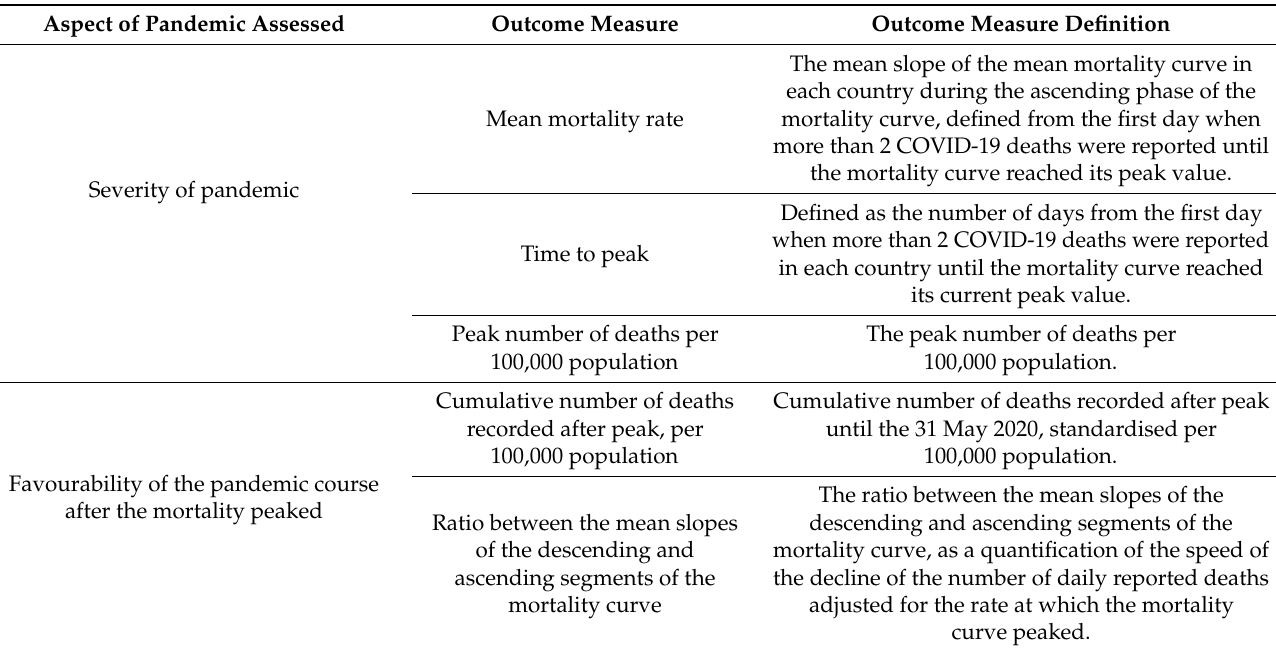
Table 1. Outcome measures and their definitions.